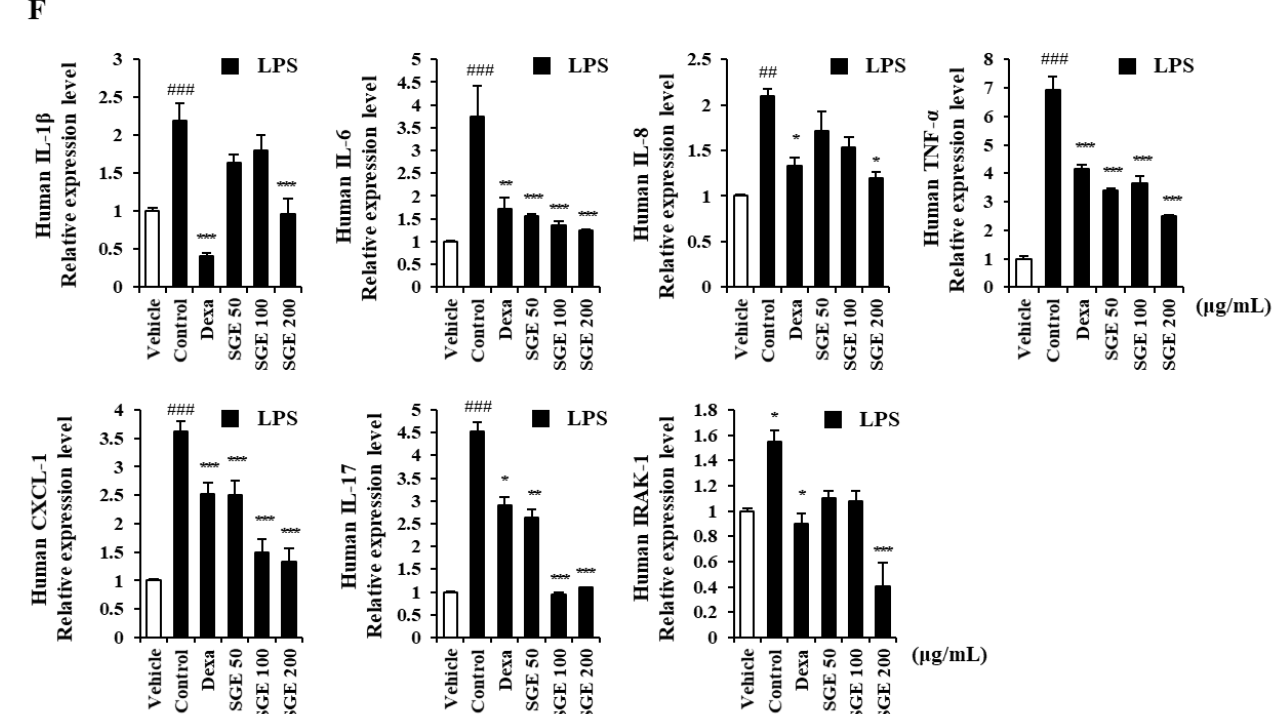
Figure 1. Effects of S. grosvenorii extract (SGE) on cytotoxicity and pro-inflammatory cytokine production in LPS-induced BEAS-2B cells. ( A ) Cytotoxicity of LPS and SGE in BEAS-2B cells was measured using the CCK-8 assay. ( B – E ) BEAS- 2B cells were treated with LPS at 20 μg/mL and SGE at 50, 100, or 200 mg/mL for 24 h. Cytokines (IL-6, IL-8, TNF- α) and MUC5AC were measured using ELISA. ( F ) The relative expression of mRNA of the genes for IL- 1β, IL -6, IL-8, TNF- α, IL -17, CXCL1, and IRAK1 in the LPS-stimulated cells. The data are presented as means ± SEM for three independent experiments. ## p < 0.01, ### p < 0.001 compared to the vehicle group. * p < 0.05, ** p < 0.01, *** p < 0.001 compared to the control group. Dexa, dexamethasone.